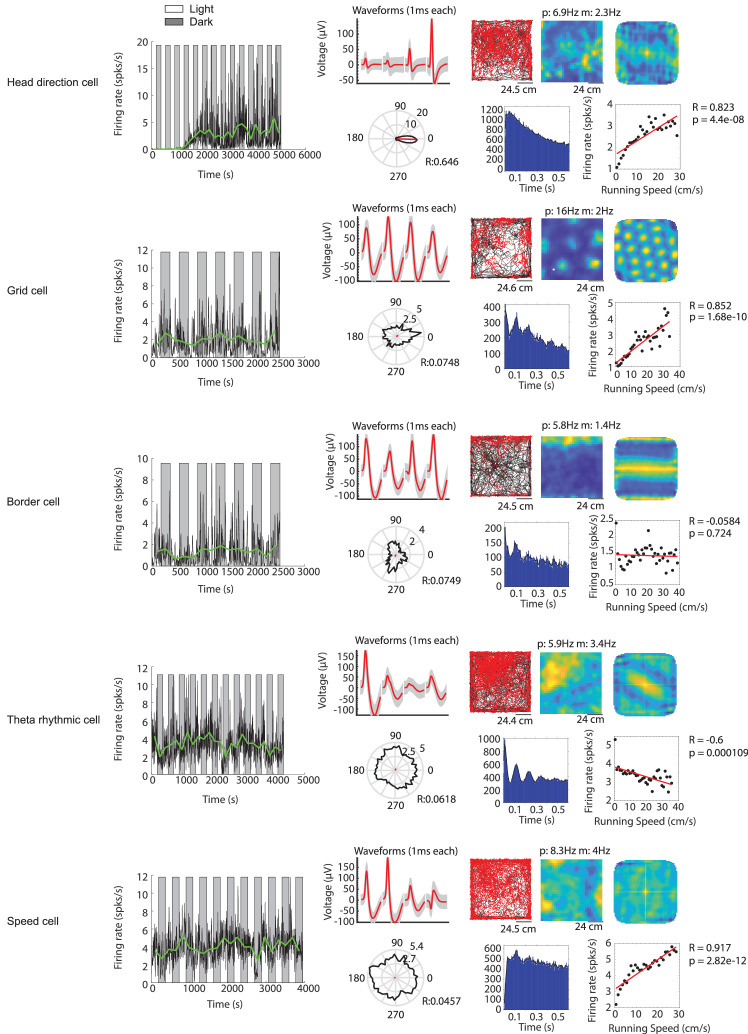
Examples of functional cell types in the medial entorhinal cortex whose baseline firing rates are modulated by visual inputs.Example cells include (from top to bottom) a head direction cell, a grid cell, a border cell, a theta rhythmic cell and a speed cell. For each functional cell type example: Left most panel shows the firing rate in 1 s time bins (black solid line) and the mean firing rate of each light or dark epoch (green solid line) for one recording session. Gray background indicates the dark condition; white background indicates the light condition. The remaining panels in the top row from left to right show the waveform plot, trajectory plot, firing rate map, and spatial autocorrelation of the firing rate map. The bottom row from left to right shows the head direction map, spike autocorrelogram, and speed tuning plot. In the waveform plot, red solid lines show the mean waveforms of all spikes for the four tetrode channels (each 1 ms long). Gray shading shows the s.e.m. of the waveform across all spikes. In the trajectory plot, black lines show the trajectory of the mouse, and red dots indicate the location of spikes on that trajectory. The firing rate map shows the occupancy-normalized firing rate per spatial bin, blue color indicates low firing rate, yellow color indicates high firing rate; p=peak firing rate; m = mean firing rate. Same color scheme applies for the spatial autocorrelation of the firing rate map. The solid black line in the head direction plot shows the occupancy-normalized firing rate per head direction bin (bin size is 15 degree) on a circular axis; numbers next to the inner and outer circle are the circular axis tick mark labels. The solid red line shows the mean resultant length; R = circular correlation. Black dots in the speed tuning plot show the mean firing rate across all data points for 2 cm/s running speed bins. The red line shows the linear regression. R = Pearson’s correlation coefficient; p=p value for linear regression.